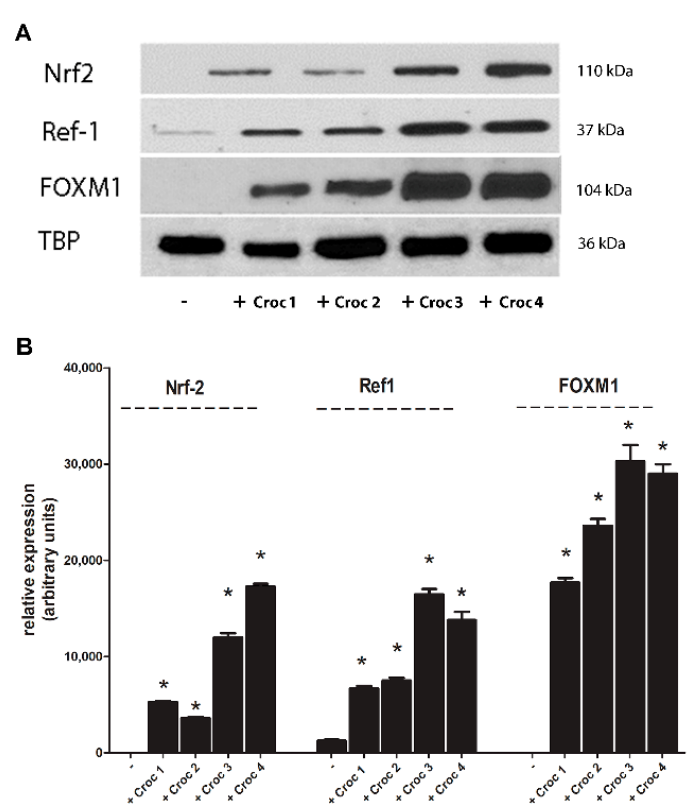
Figure 6. Increased expression of Nrf2, Ref-1 and FOXM1 after crocidolite asbestos exposure. ( A ) Western Blot of nuclear extracts of Nrf2, Ref-1 and FOXM1 from HMC untreated (-) or treated (+) for 24 h with crocidolite (Croc) asbestos (Croc 1: 1 µg/cm 2 ; Croc 2: 5 µg/cm 2 Croc 3: 10 µg/cm 2 ; Croc 4: 25 µg/cm 2 ). ( B ) Densitometric analysis of the relative expression of Nrf2 ( n = 3, * p < 0.001), Ref-1 ( n = 3, * p < 0.001) and FOXM1 ( n = 3, * p < 0.001), respectively .